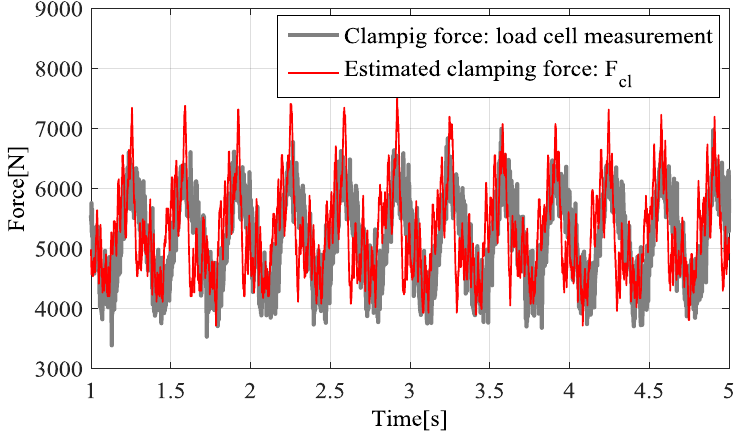
Figure 7. Experimental results for a CFO.